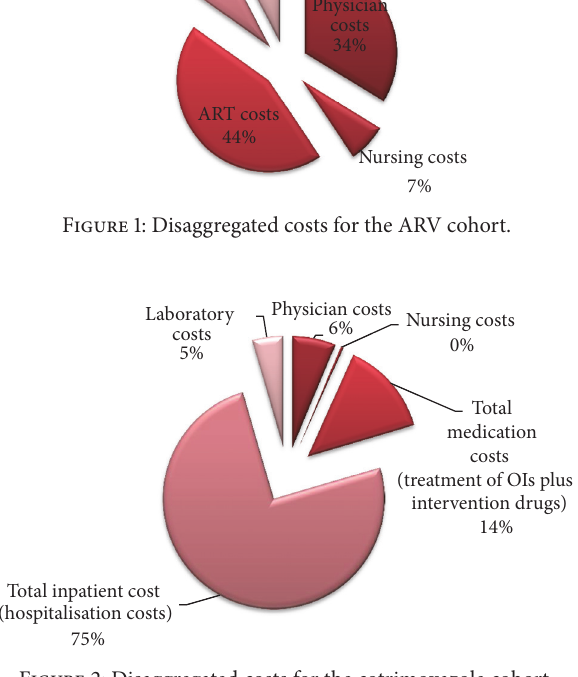
Figure 2: Disaggregated costs for the cotrimoxazole